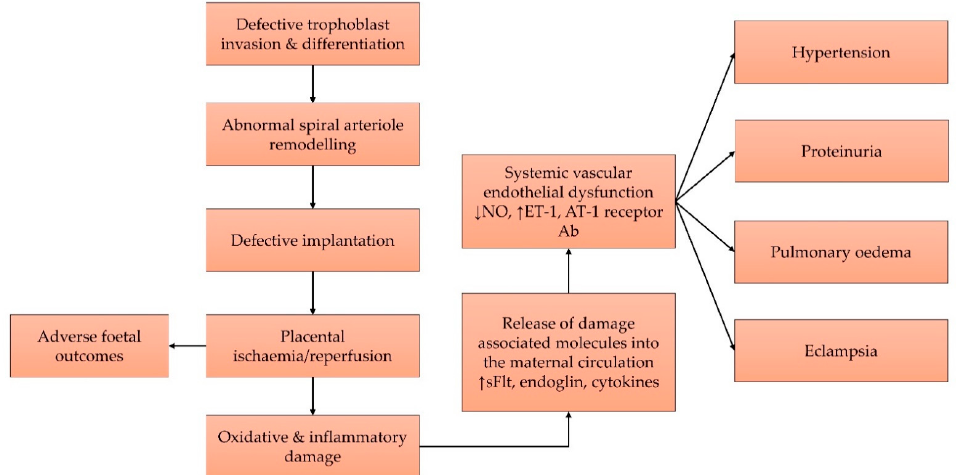
Figure 1. Pre-eclampsia begins with defective placental implantation, which leads to recurrent ischaemia and reperfusion cycles that result in oxidative and inflammatory damages to the tissue. Damage-associated molecules cause systemic endothelial dysfunction and various features of pre- eclampsia. Abbreviations: Ab, antibody; AT-1, angiotensin-1; ET-1, endothelin-1; NO, nitric oxide; sFlt-1, soluble fms-like tyrosine kinase 1.